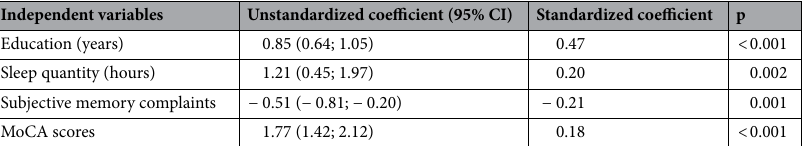
Table 2. Univariable associations with evaluator-reported